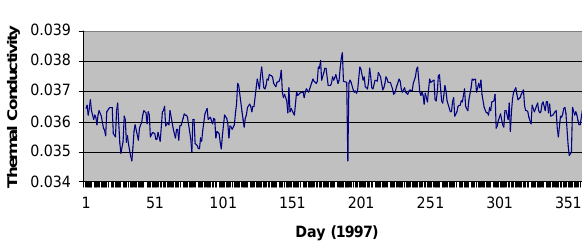
Fig. 3. Daily variation of thermal conductivity (850hPa, 1997). Table 3. El Ni˜no and La Ni˜na years in the observation